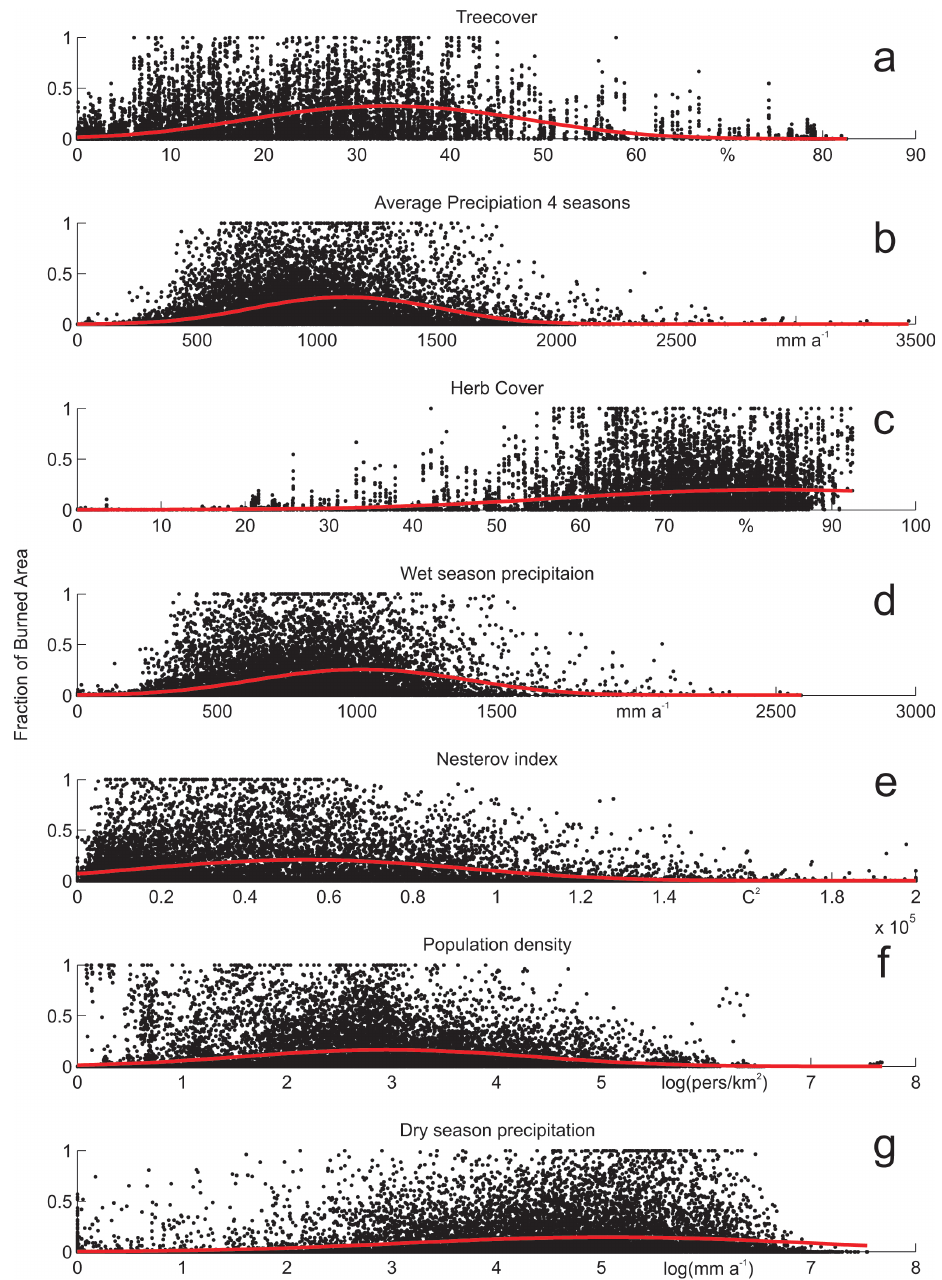
Fig. 3. Response of burned area to the variables tree and herb cover, precipitation (average over the last four seasons, last wet season, last dry season) and population density. The correlation coefficients as well as the model parameter for each variable are listed in Table